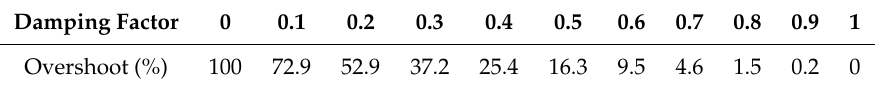
Table 2. Percentage of overshoot for different damping factor values.